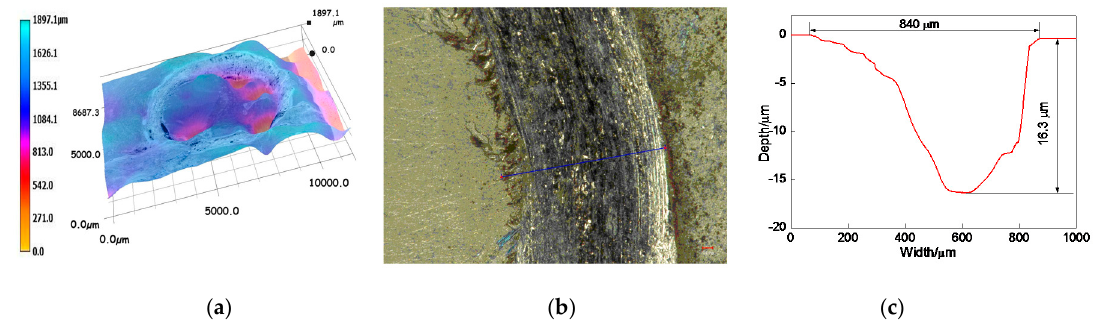
Figure 12. Profile of worn track on 17% Cr–83% Ni coating. ( a ) Overall profile of worn track; ( b ) Measured position of worn track; ( c ) Profile of worn track.